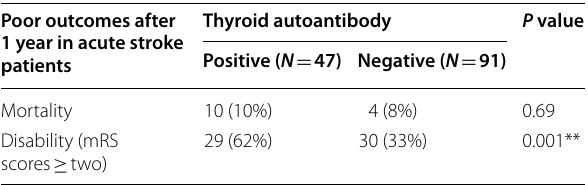
Table 2 Relation between thyroid autoantibody and poor